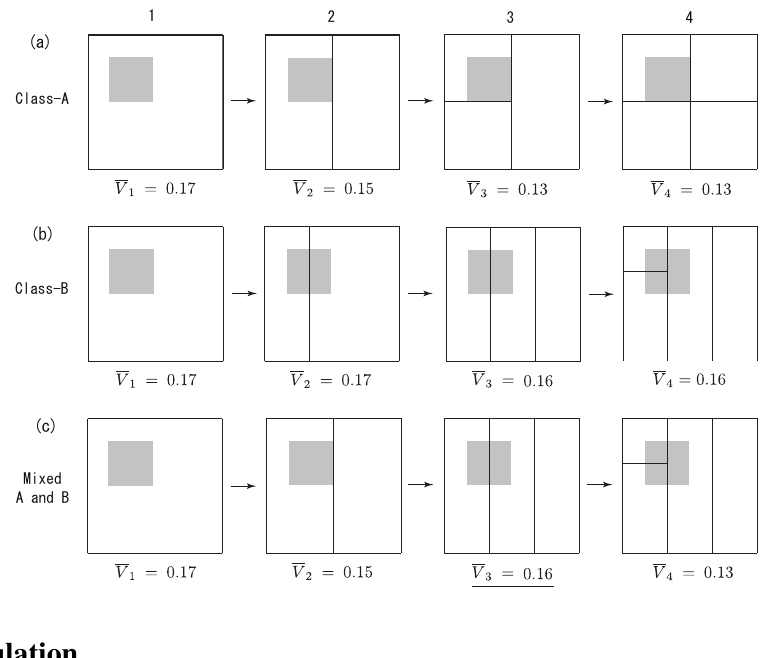
Figure 8. Illustration of the resolution transform from resolution levels 1 to 4. ( a ) and ( b ) describe the elements of the resolution sequences class A and class B, respectively. ( c ) depicts the elements of a resolution sequence in which elements from both class A and class B are included. The average NDVI varies monotonically in (a) and (b). In contrast, non-monotonic behavior is observed in (c) at the resolution level